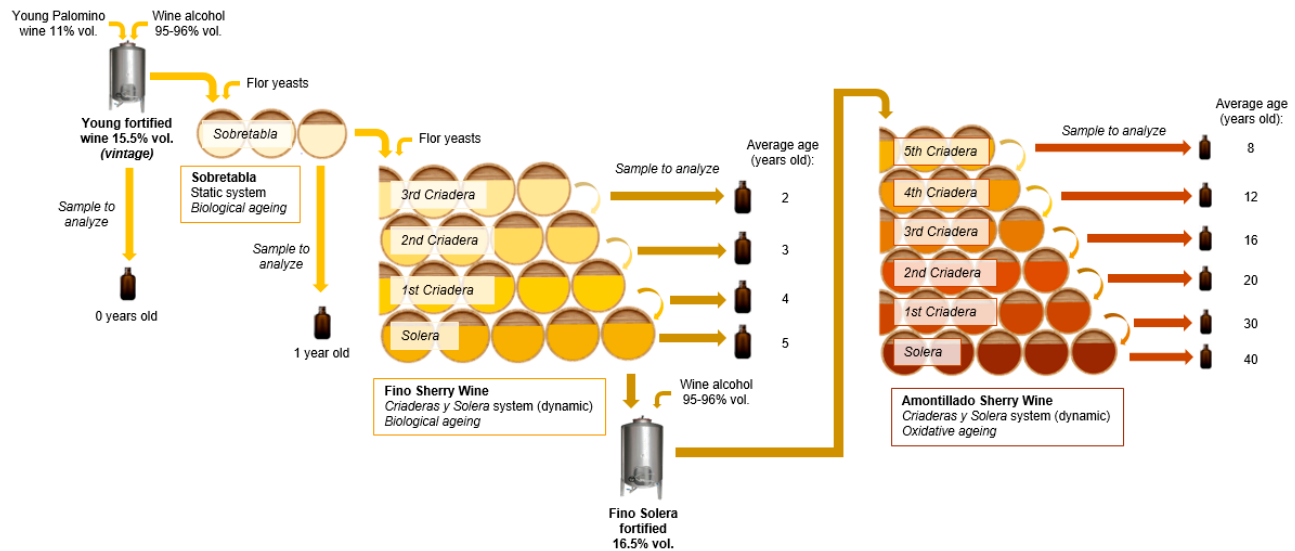
Figure 1. Diagram of the studied aging process and sampling.